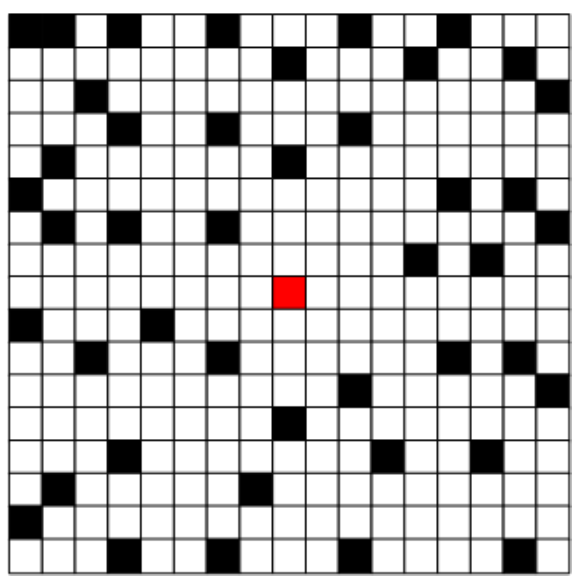
Figure 10. Schematic diagram of camera switch status. The center red is always on by default, the black part is off, and the white part is on.